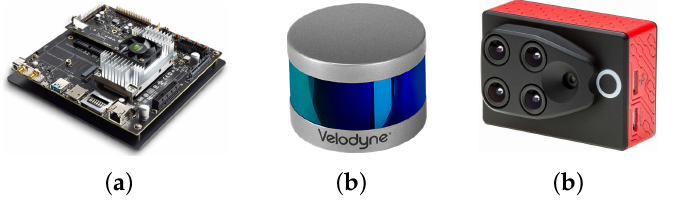
Figure 1. The selected embedded system and sensors. ( a ) Jetson TX2 ( b ) VLP-16 LiDAR ( c ) Sequoia